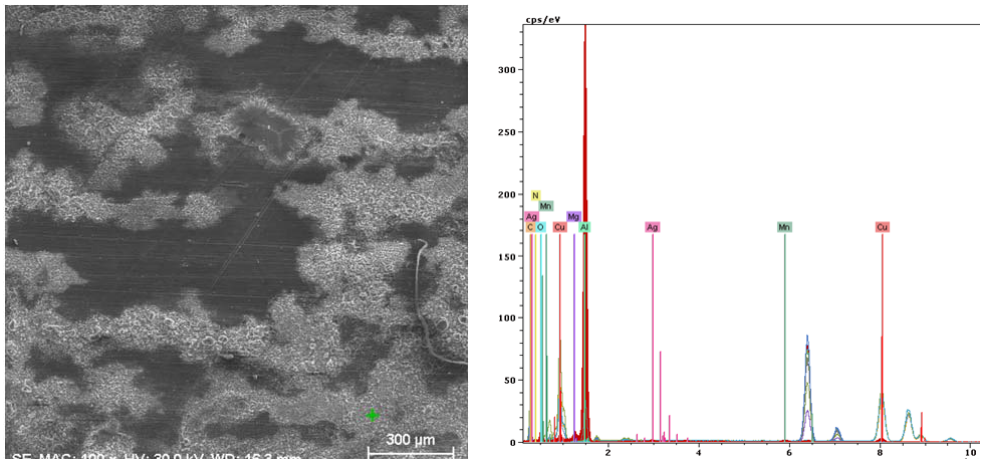
Figure 4. SEM and EDX analysis of AlCu4Mg1 aluminum alloy sample surface